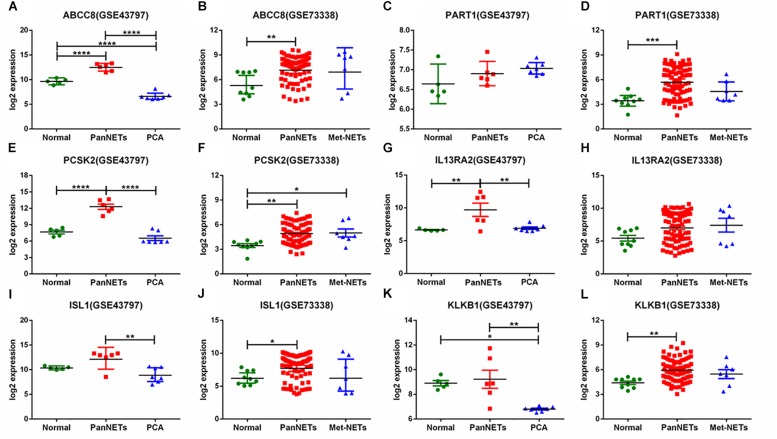
Six gene expression levels in PanNETs, PCA, and normal pancreatic tissues. (A,C,E,G,I,K) are the expression levels of six genes in GSE43797. (B,D,F,H,J,L) are the expression levels of six genes in GSE73338. PCA = ductal adenocarcinoma, PanNETs = pancreatic neuroendocrine tumors, Met-NETs = metastases from pancreatic neuroendocrine tumors. ∗P <c 0.05, ∗∗P < 0.01, ∗∗∗P < 0.001, ****P < 0.0001.